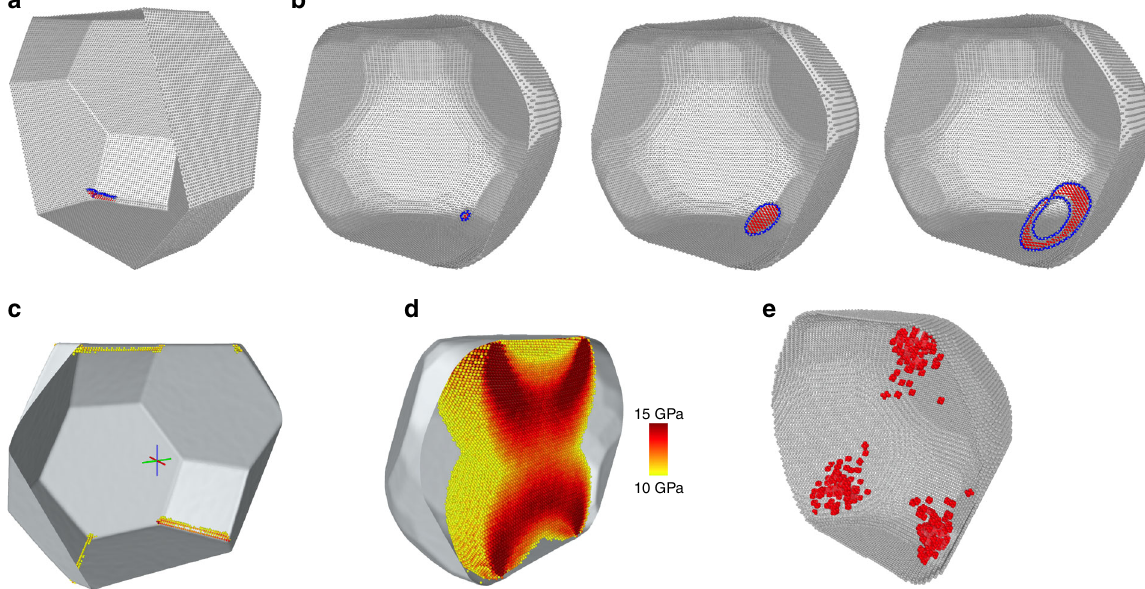
Fig. 8 Two dislocation nucleation mechanisms in Ni nanoparticles. The initial particle diameter was 20 nm. For visual clarity, the particle was sliced in halves, perfect FCC atoms were removed, and thermal noise was eliminated by static relaxation. The Shockley partial dislocations and stacking faults are shown in blue and red, respectively. a Heterogeneous dislocation nucleation in the particle corner. b Stages of homogeneous dislocation nucleation inside the particle. c , d Resolved shear stress distribution in a Wulff particle ( c ) and in a rounded particle ( d ) just before the dislocation nucleation. Note the relatively uniform, hourglass shape, stress distribution penetrating deep into the rounded particle. The stress was averaged over 7.7 ps to remove thermal noise. Only atoms with resolved stress exceeding 10 GPa are shown, with the darker color representing larger stresses. e Overlap of hot spot locations (red) at several points of time showing their localization in certain zones inside the